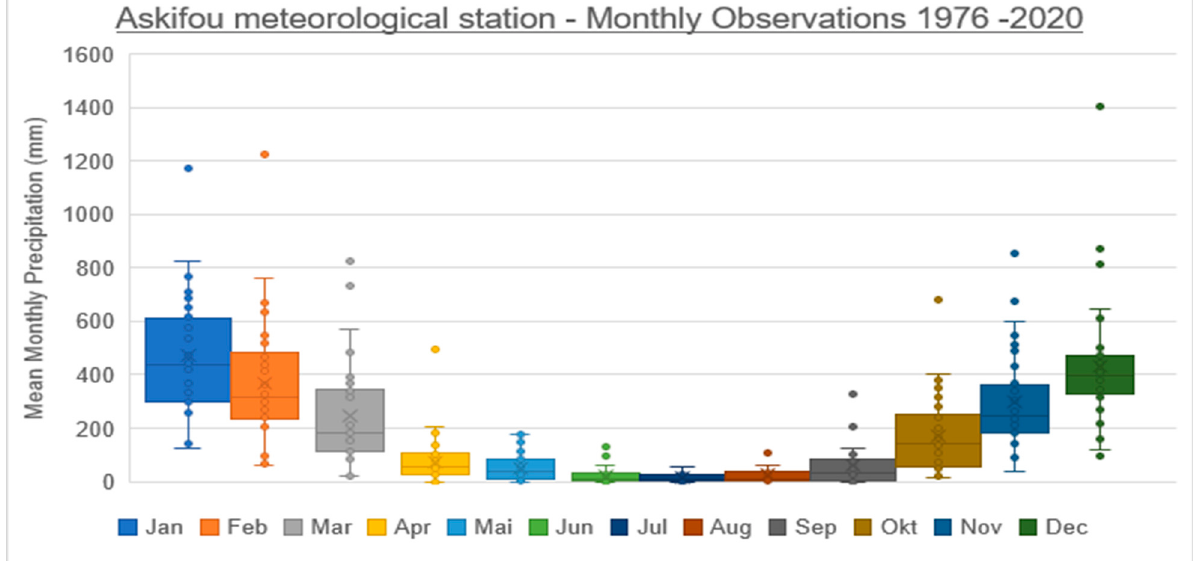
Figure 4. Boxplots of the mean monthly precipitation (total precipitation per month) of the Askifou station from 1976 to 2020.